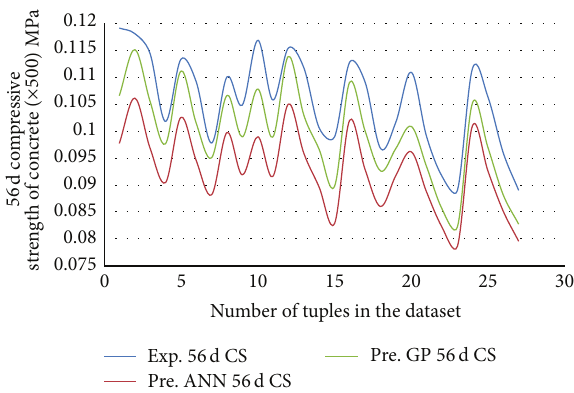
Figure 5: Comparison between actual and predicted values of 56 d compressive strength of concrete with